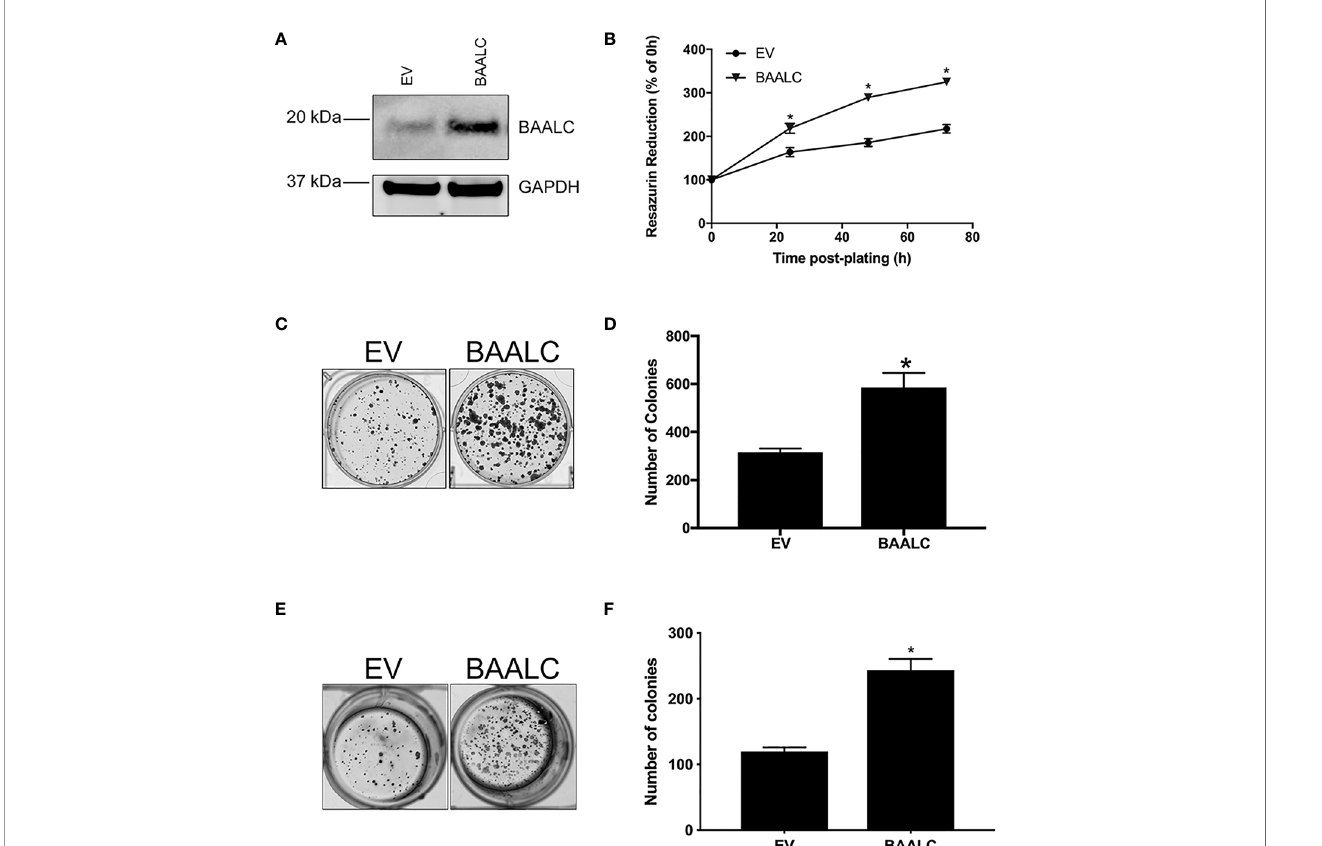
FIGURE 3 | BAALC overexpression increases breast cancer cell proliferation and anchorage-independent growth in vitro . MCF-7 cells stably transfected with an empty vector (EV) or BAALC were generated. (A) Top BAALC expression was con fi rmed by western blot, bottom GAPDH as a loading control. (B) Cell viability was measured at 0, 24, 48, and 72 h post-plating via Cell Titre Blue Assay. n=3 in triplicate. (C) Transduced MCF-7 cells were grown for 14 days. After this time colonies were stained with 0.5% crystal violet/10% methanol/PBS for 30 mins. Photomicrographs are representative of three independent experiments, performed in triplicate. (D) Colonies were counted. (E) Transduced MCF-7 cells were grown for 15 days in soft agar before the colonies were stained with 0.5% crystal violet/10% methanol/PBS for 30 mins. Photomicrographs are representative of four independent experiments, performed in duplicate. (F) After staining, the colonies in each well were counted. * denotes statistical signi fi cance p < 0.05, as determined by an unpaired two-tailed